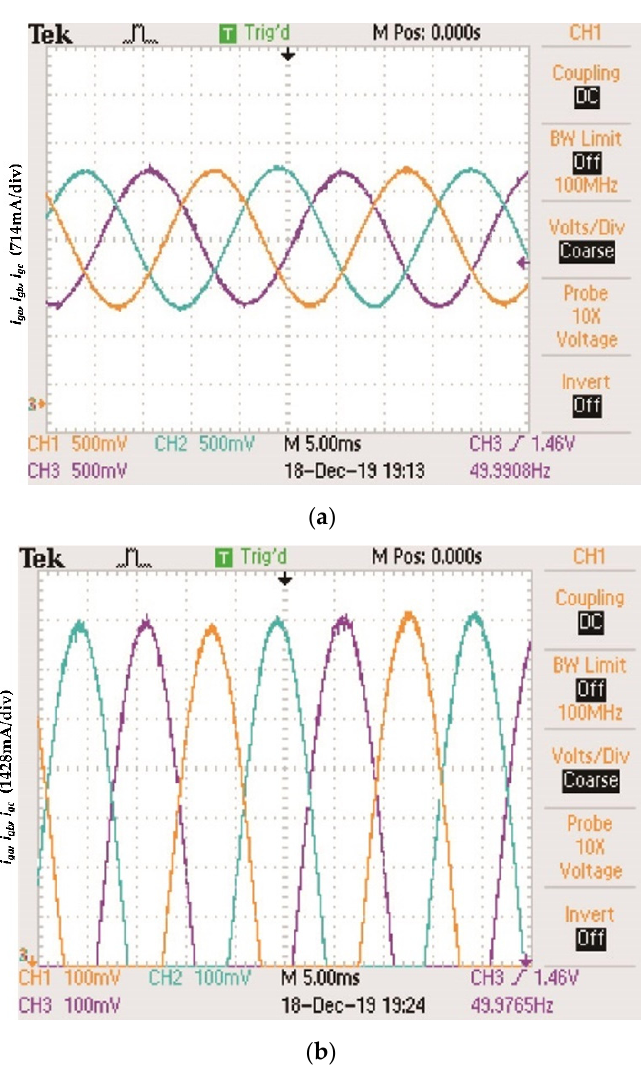
Figure 8. Waveforms of the grid current with the dc current at different current reference with the proposed scheme. ( a ) i dref = 1 A. ( b ) Zoom-in detail of Figure 8a.